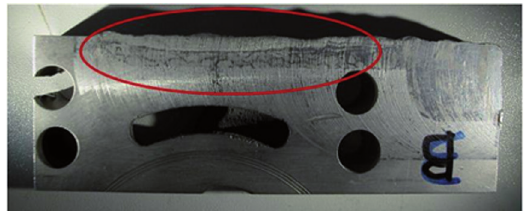
Figure 3: Macrograph of a sample repaired through CGDS; the red circle highlights the repaired zone.